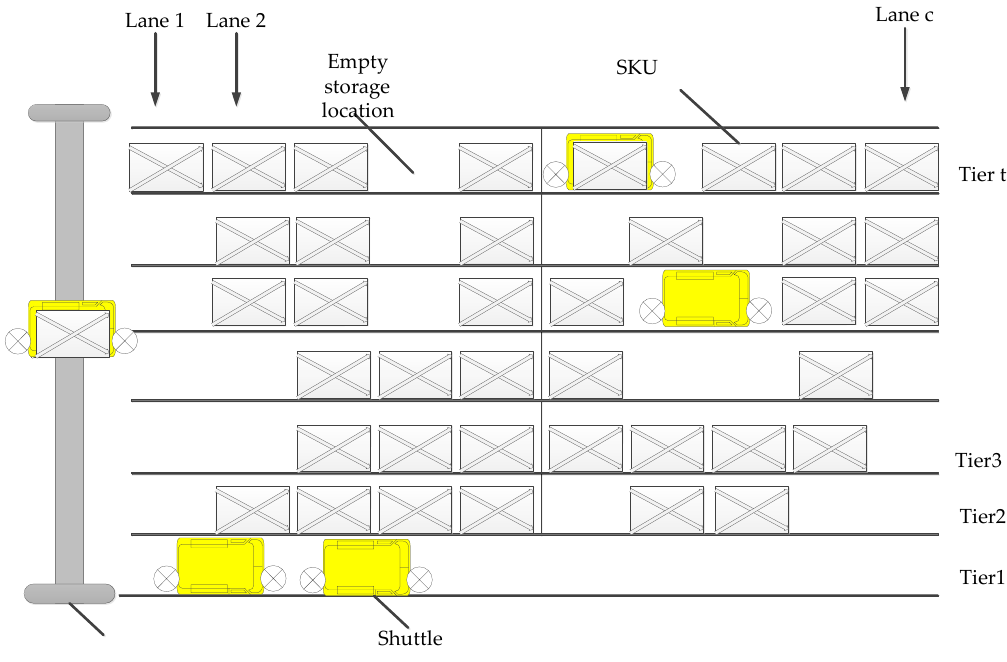
Figure 1. Tier-to-tier SBS/RS configuration.